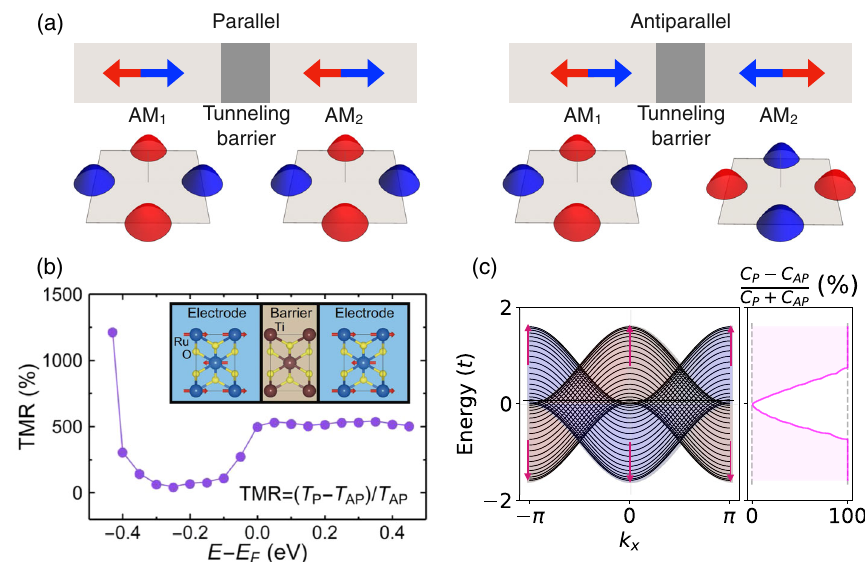
FIG. 13. (a) Schematics of a TMR stack with an insulating barrier and altermagnetic electrodes with parallel and antiparallel order vectors. Energy band cuts highlight the oppositely split valleys, resulting in valley and spin-dependent densities of states. (b) Ab initio quantum-transmission calculations of the TMR in a RuO 2 j TiO 2 j RuO 2 tunnel junction. (c) Model spin and transport-momentum projected band structure, and relative difference between the conductances in the parallel and antiparallel configurations of the altermagnetic-order vectors in the two electrodes. The TMR is maximized for transport energies corresponding to the spin-split valleys well separated in momentum. This figure is adapted from Refs.